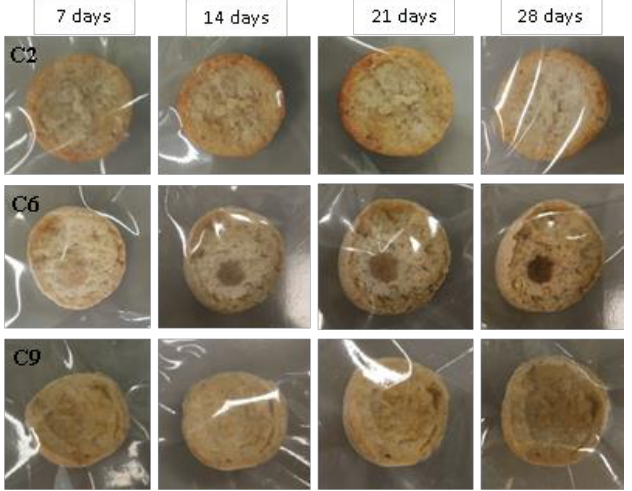
Figure 7. Examples of bread made from sourdoughs inoculated with the combination of isolates C2, C6, and C9, and then artificially contaminated with A. flavus and incubated at room temperature for 7, 14, 21, and 28 days.